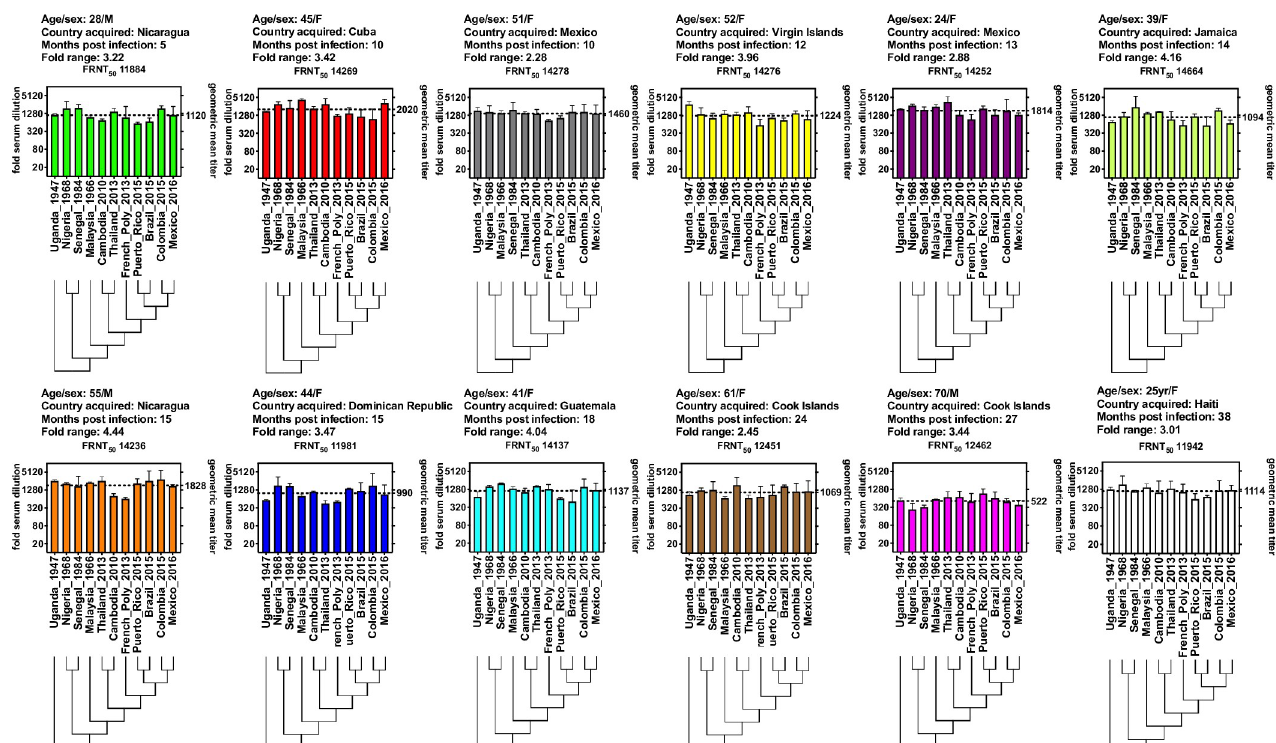
Fig 2. FRNT 50 titers for subject sera against each virus. Fold serum dilution is shown on the left Y-axis, geometric mean titer (GMT) for each subject against all 11 viruses is plotted on the right Y-axis. Viruses and their relative phylogenetic relationships are shown on the X-axis. Subject age, gender, country infection acquired, months post-infection and fold-FRNT 50 range are reported above each serum plot. The sera are ordered left to right from most recent to most remote infection.